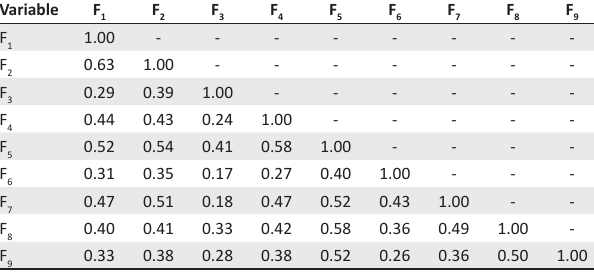
TABLE 4: Correlations between the extracted factors (adapted structural configuration of the Human Resource Practices Perceptions Questionnaire). Variable F 1